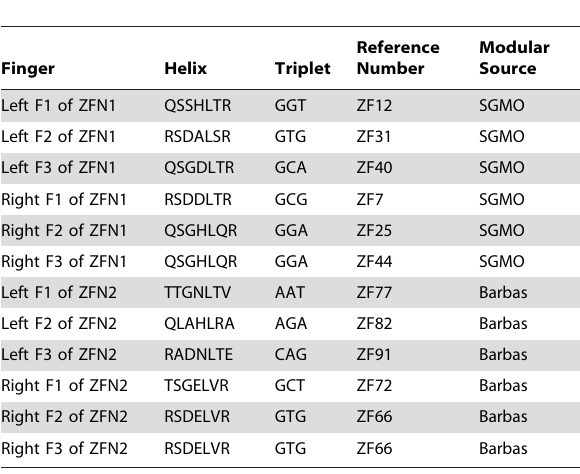
Table 1. Zinc fingers used in ZFN1 (active) and ZFN2 (inactive)*.